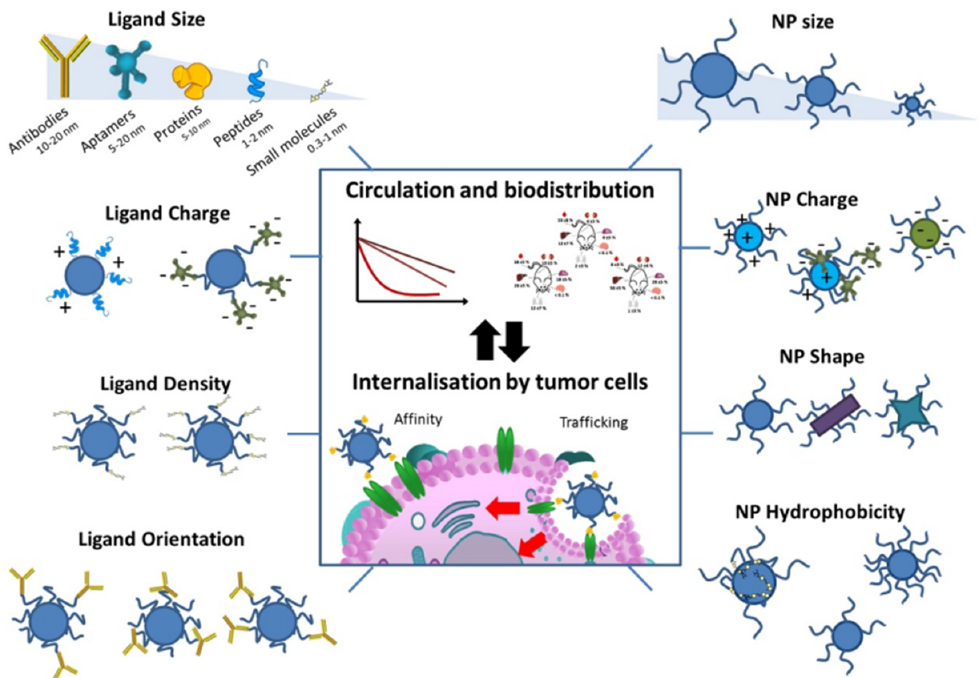
Figure 4. The physicochemical properties of the ligand and the NP affect their blood circulation profiles, their biodistribution, and their ability to be internalized by cancer cells. (Reprinted from [74], with permission from Elsevier).